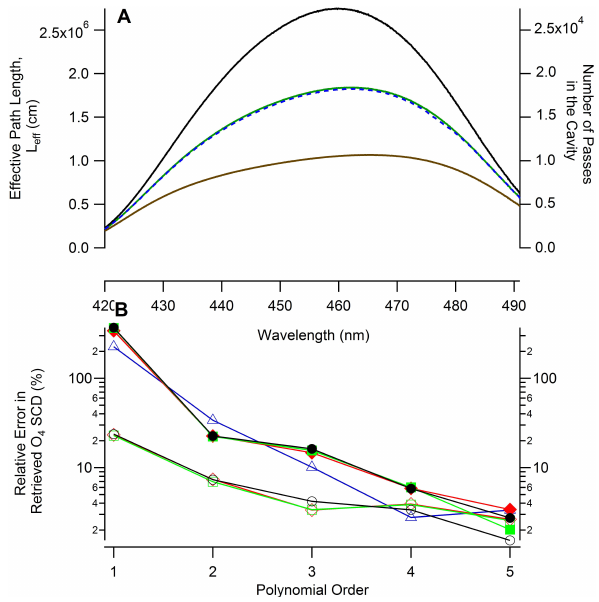
Fig. 6. Effect of mirror reflectivity and high pass filter on the O 4 retrieval. (A) Effective path length and number of traverses in the cavity in helium (black), nitrogen (green), air (blue) and air with aerosol (brown, ε Mie =3 × 10 − 7 cm − 1 ) calculated from theory us- ing known Rayleigh cross-sections and the aerosol extinction cross- section from Mie theory (Bodhaine et al., 1999; Sneep and Ubachs, 2005). (B) The relative error in the retrieved O 4 slant column re- trieved compared to the calculated O 4 slant column as a function of polynomial order of the high pass filter. Open green squares: air spectrum fit against a nitrogen reference with F (Eq. 5) for the Rayleigh case; open black circles: air spectrum, nitrogen ref- erence, Aerosol case scaled cross-section; open red diamonds: air spectrum, nitrogen reference, sum of two cross-section fit; open blue triangles: air spectrum, He reference, Rayleigh case cross- section; closed green squares: Aerosol spectrum, nitrogen refer- ence, Rayleigh case cross-section; closed black circles: aerosol spectrum, nitrogen reference, Aerosol case cross-section; closed red diamonds: aerosol spectrum, nitrogen reference, sum of two cross- section